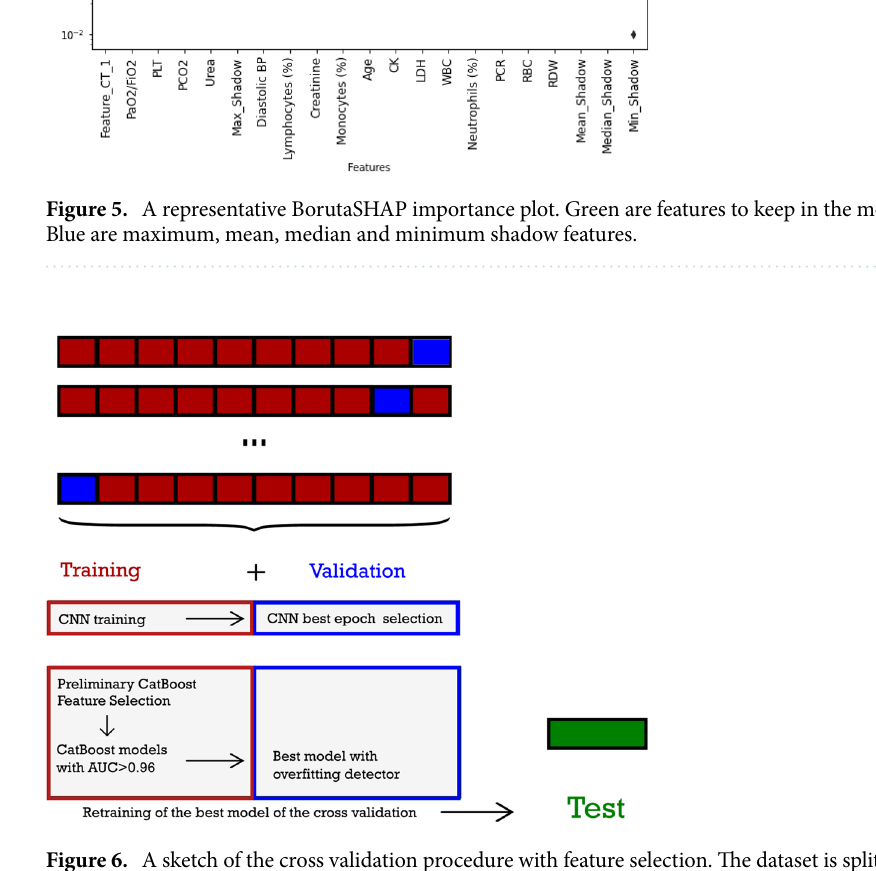
Figure 6. A sketch of the cross validation procedure with feature selection. The dataset is split in test, used only for final evaluation, and training/validation, used for CNN training and evaluation, deep learned feature extraction, feature selection and hyperparameter tuning. Ten fold cross validation is applied in the training/ validation set. CNN is trained on the training set (upper left red box), evaluated for hyperparameters on the validation set (upper right blue box). Extracted features are combined with non-imaging features, and selected in the training set, with a preliminary model (lower left red box: Preliminary CatBoost+Feature Selection). Bayesian optimization with Optuna is used for the preliminary model hyperparameters choice. Feature selection is effected with BorutaSHAP. CatBoost hyperparameters tuning on the selected feature set was effected in two steps, first with abayesian optimization in order to reduce the hyperparameter (lower left red box: CatBoost models with AUC > 0.96 ) and then with overfitting detector (lower right blue box: best model in validation set). The best model of cross validation is retrained on the combined training/validation set, and evaluated on the